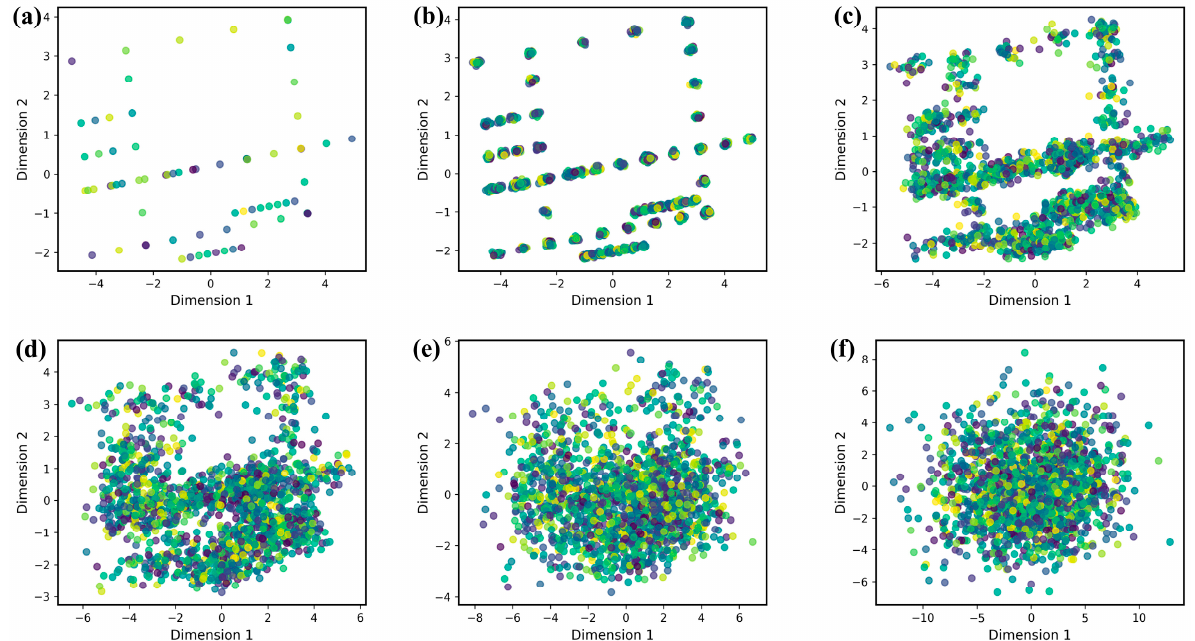
Figure 2. Comparison of data distribution plots after choosing different λ values for interpolation. ( a ) λ = 0, ( b ) λ = 0.05, ( c ) λ = 0.1, ( d ) λ = 0.2, ( e ) λ = 0.5, ( f ) λ = 1.